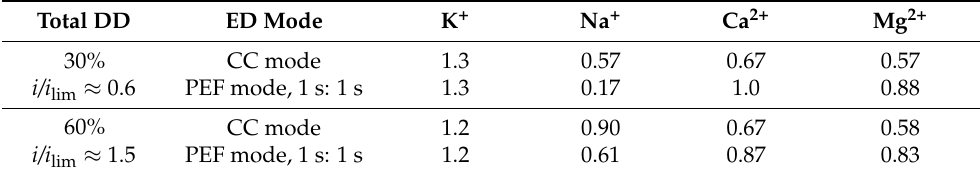
Table 1. The total degree of desalination (DD) of sweet whey and the ratio of the DD by individual ions to the total DD, θ k